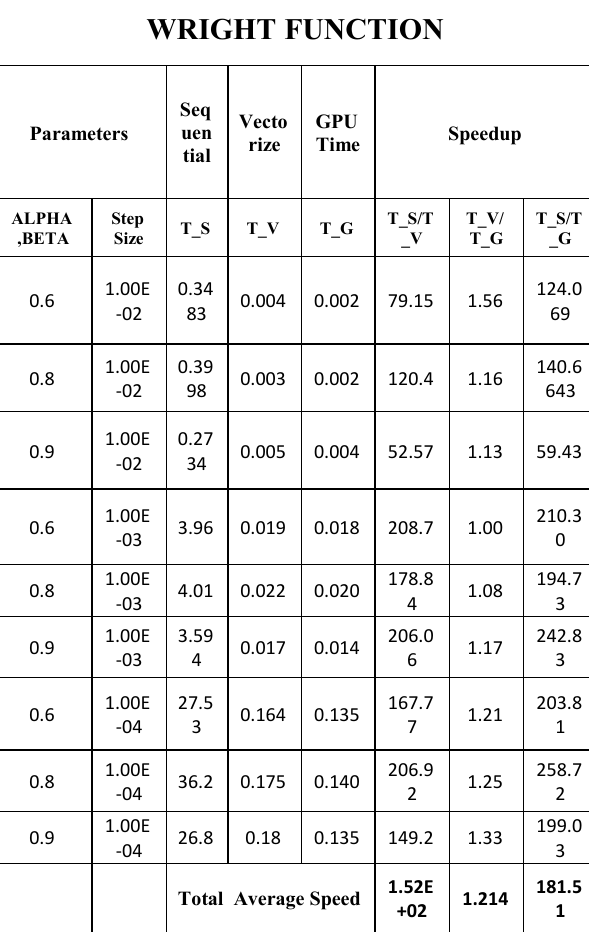
Table 3. : SpeedupTime for Wright Function